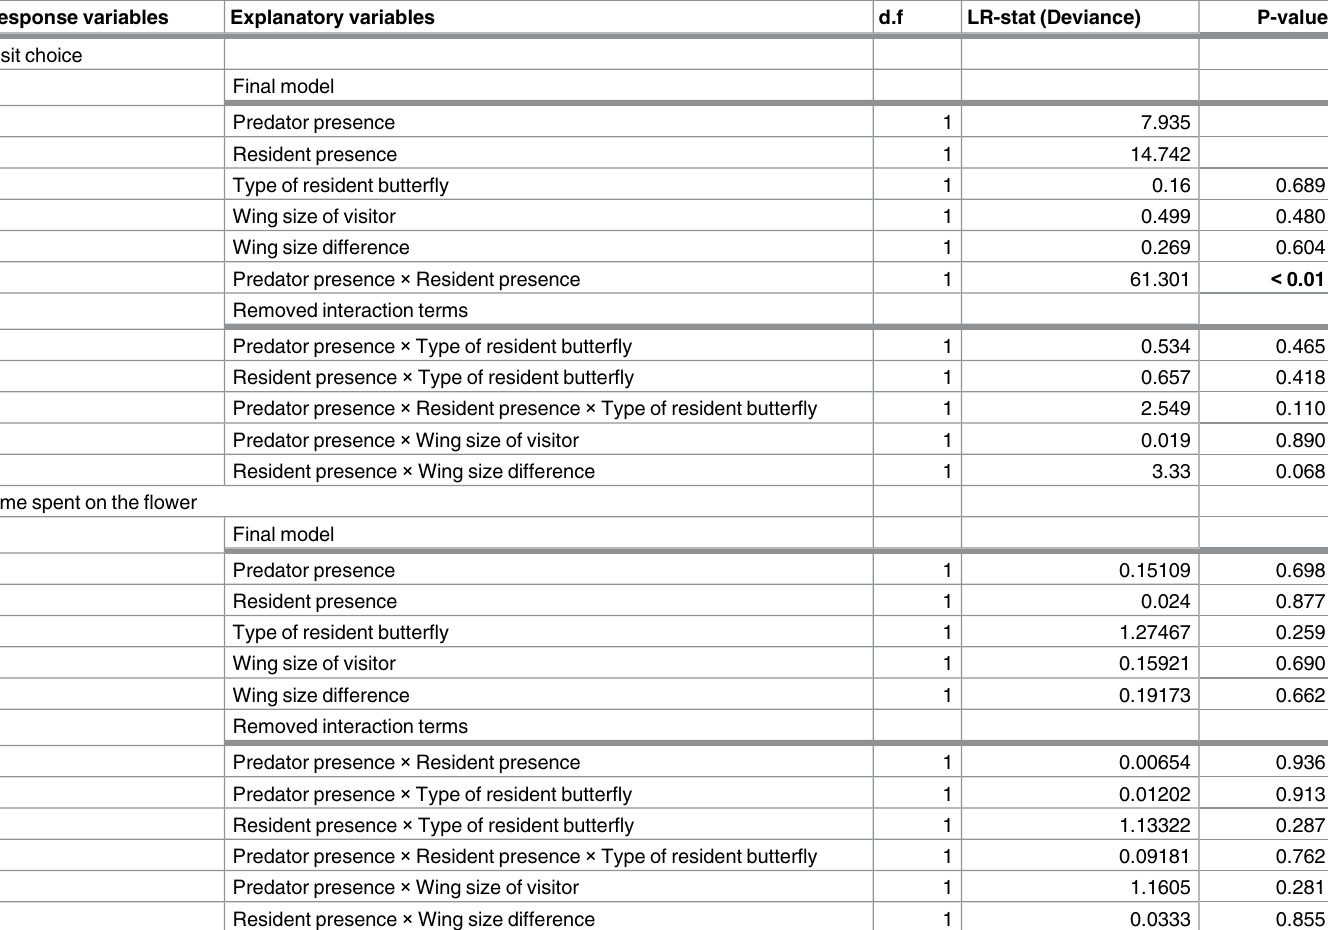
Table 3. Effects of presenceof dead predator, presenceof resident butterfly, type of resident butterfly (conspecific or heterospecifics), wing size of the visiting butterfly species, wing size difference between visitor and resident butterfly species and their interactions on the visit choice and the time spent on the